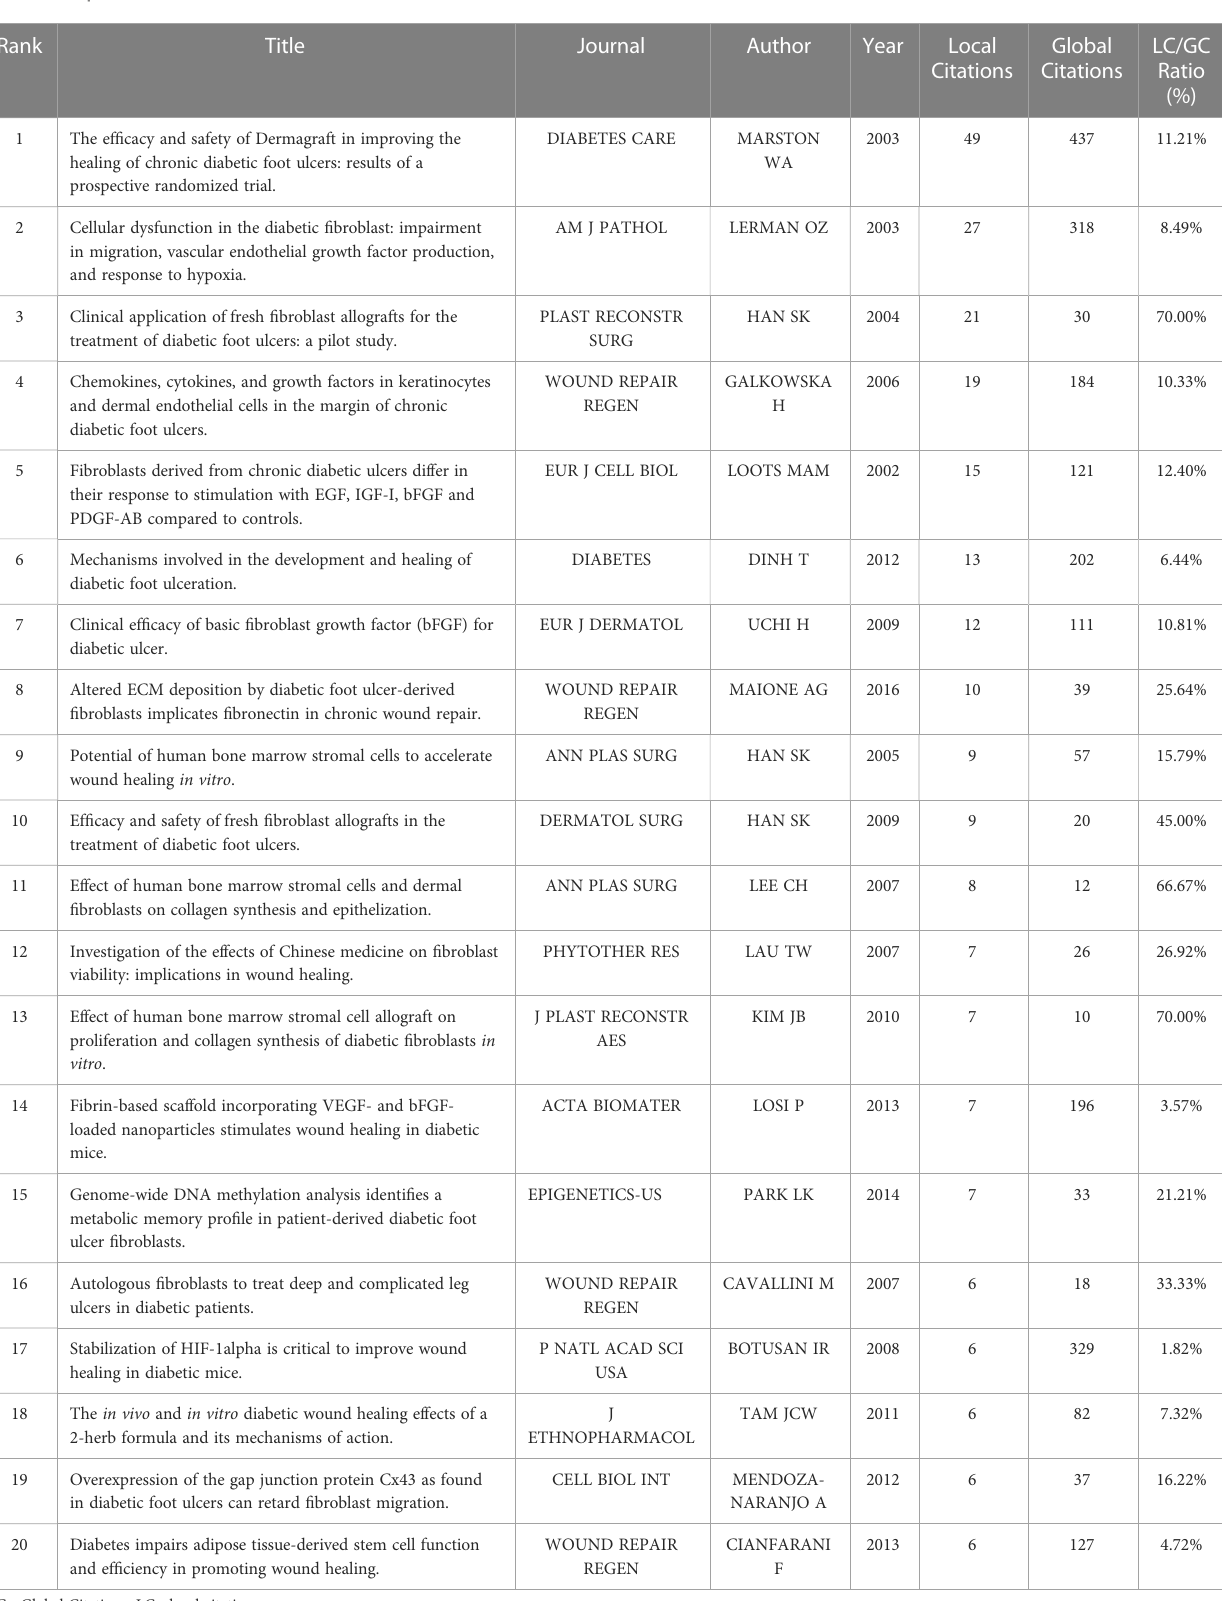
TABLE 2 Top 20 most local cited documents for fi broblast-related DFUs research. Rank Title Journal